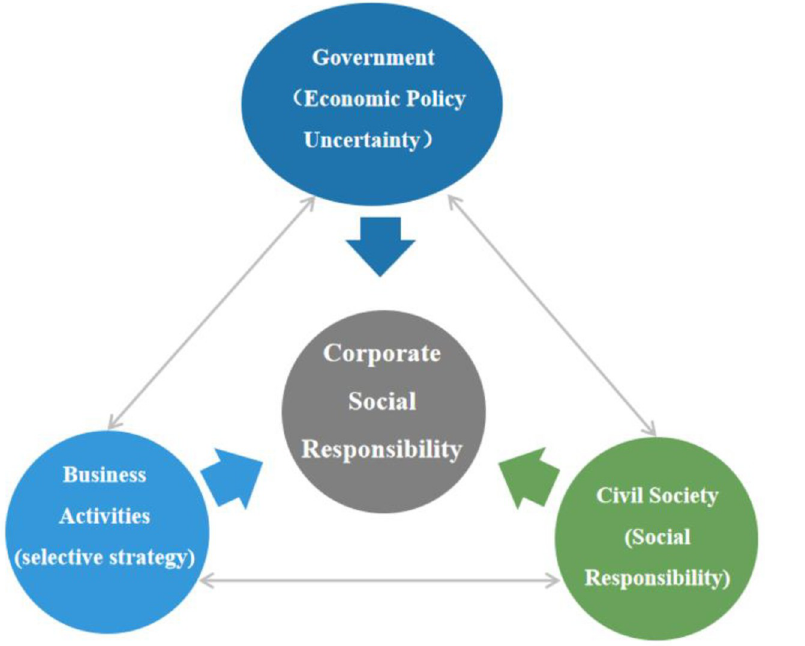
Fig 1. Conceptual mapping of EPU-CSR